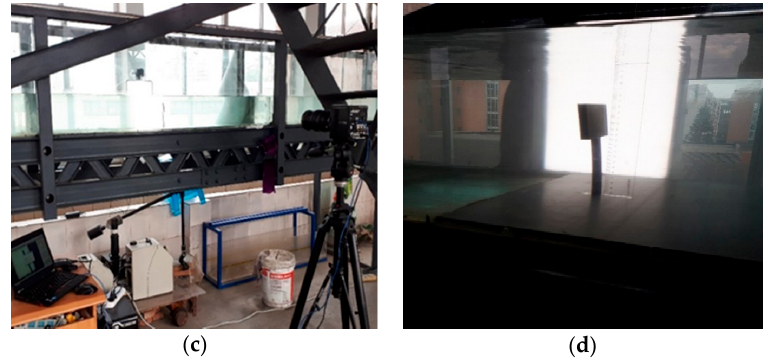
Figure 2. Schematics of the experiment setup: ( a ) experimental arrangement in the recirculating water flume; ( b ) high-speed camera on one side of the flume; ( c ) and ( d ) side views. The standardization tests were carried out in still water in order to determine the actual distance per pixel (Figure 3). The field of view was approximately 12.07 cm × 20.07 cm, leading to a spatial resolution of 0.0196 cm pixel − 1 .